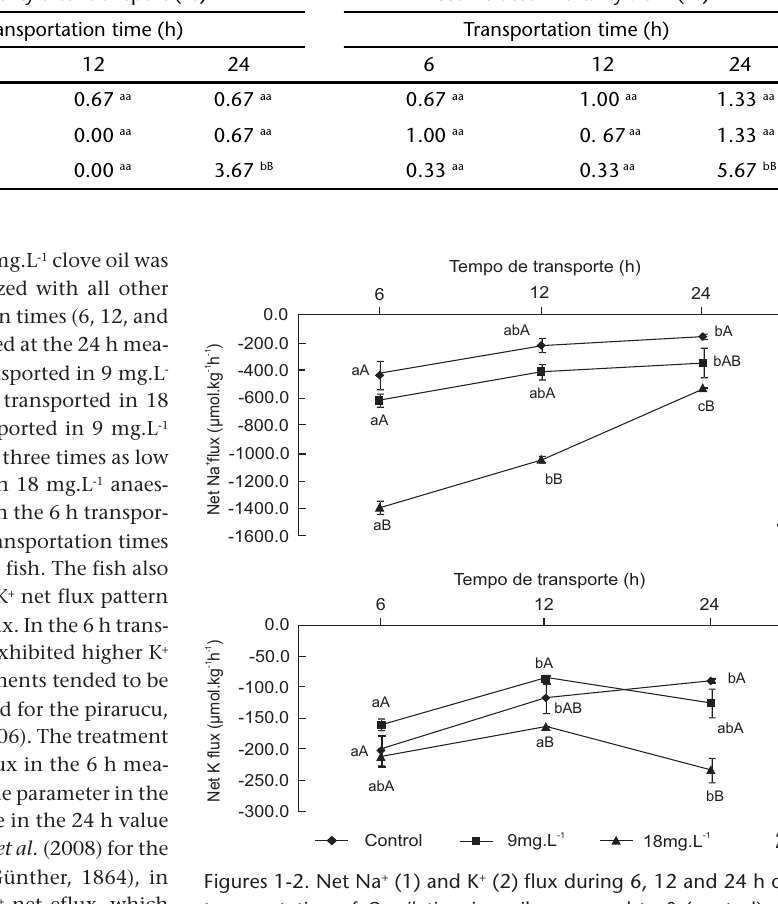
Table III. Accumulated mortality (96 h after transportation), of O. niloticus juveniles for different times and at different clove oil concentrations. Data were analyzed by two-way ANOVA and Tukey test (p < 0.05). Lower case letters indicate statistical difference of the different treatments at one same transportation time. Upper case letters indicate statistical difference of different transportation times for one same treatment. Clove oil Concentration (mg.L -1